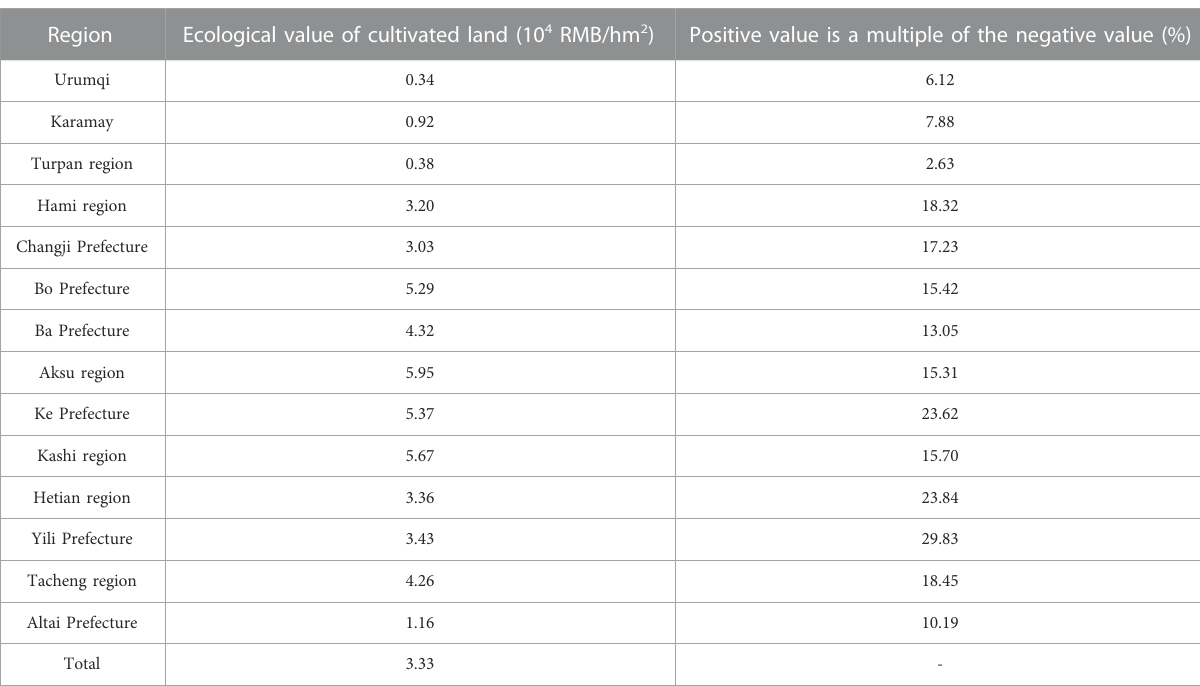
TABLE 5 Ecological value of cultivated land in state